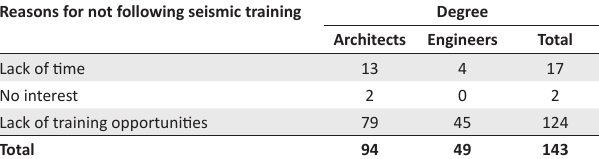
FIGURE 4: Seismic engineering training. TABLE 3: Reasons for the lack of seismic training in BETs (Bureau d’Etudes Techniques).